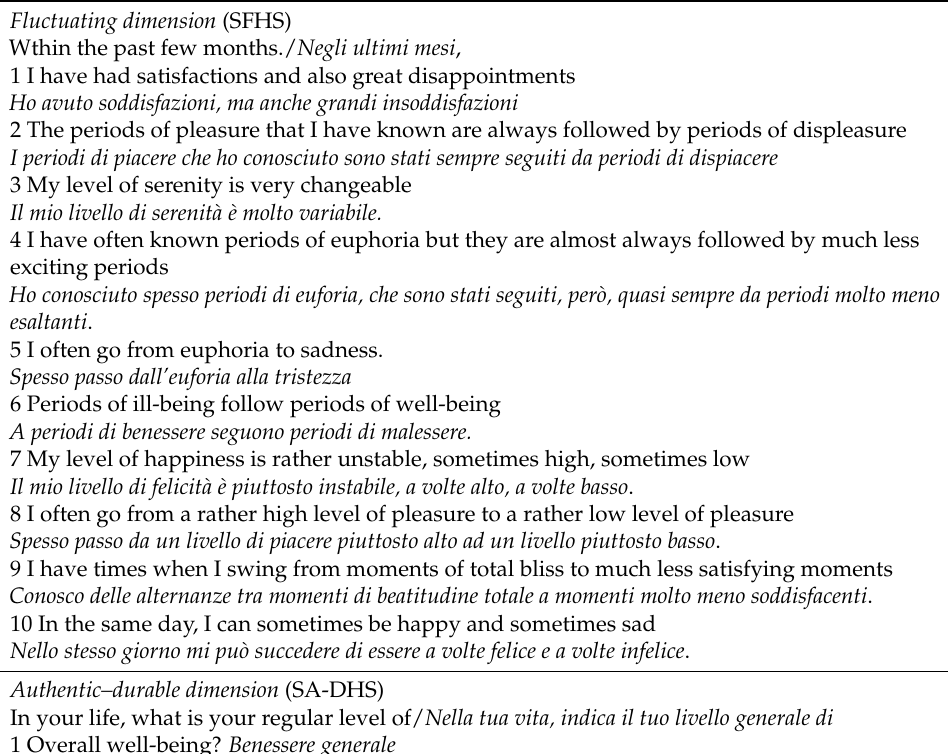
Table A1. The Italian version of the happiness